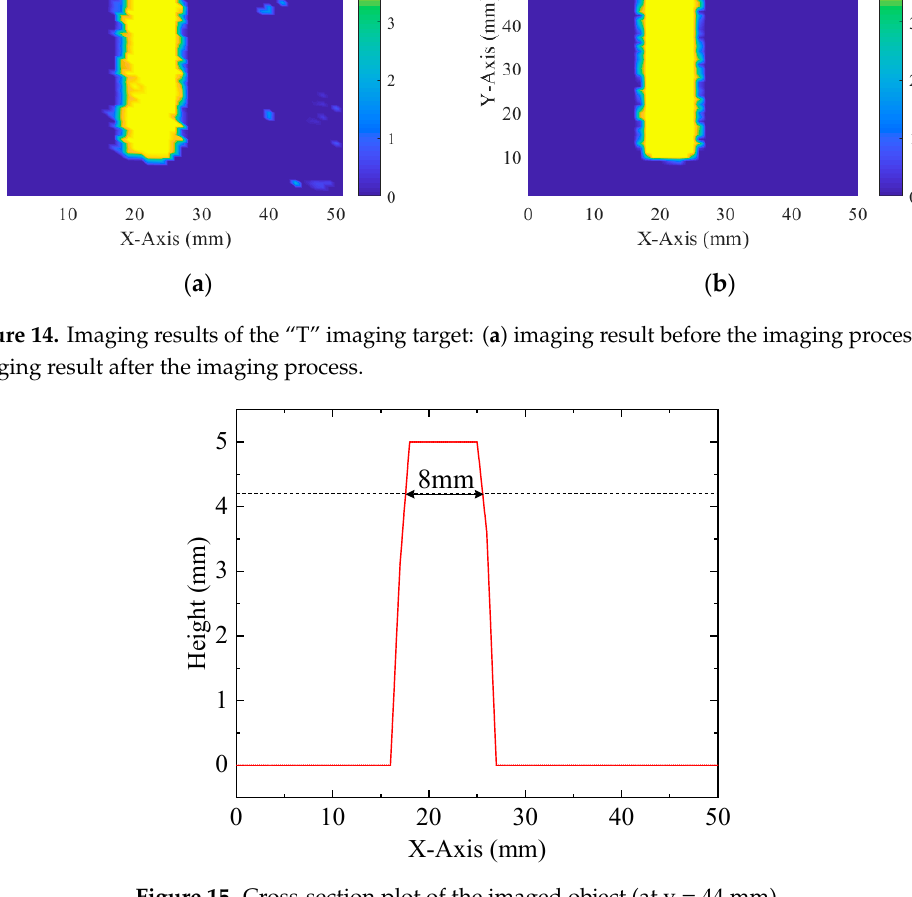
Figure 15. Cross-section plot of the imaged object (at y = 44 mm).